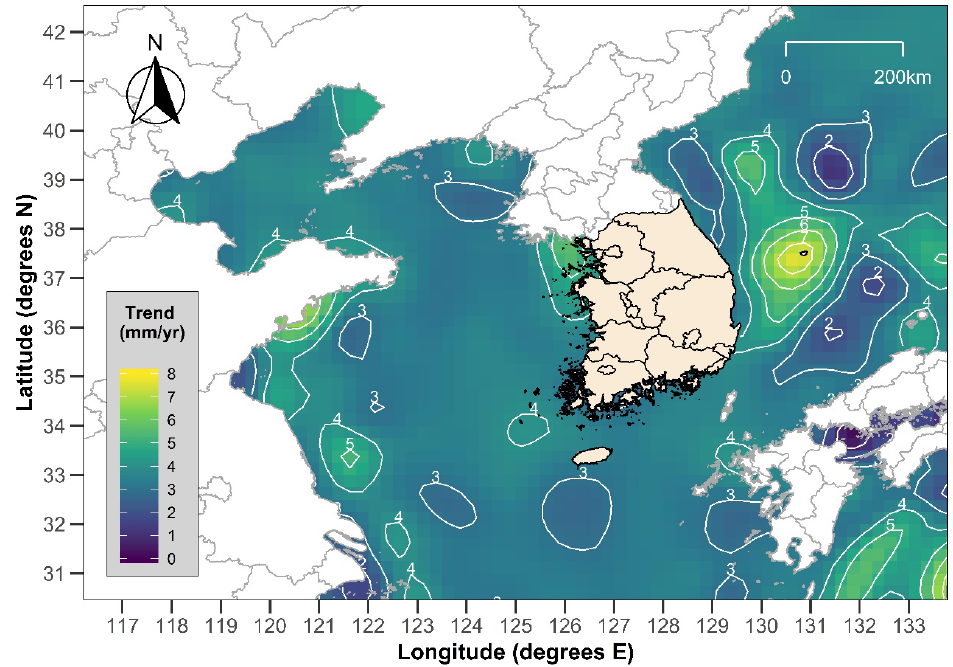
Figure 4. SSHA trends (September 1992–May 2019) from AVISO [20]. Trends have not been adjusted for Glacial Isostatic Adjustment.